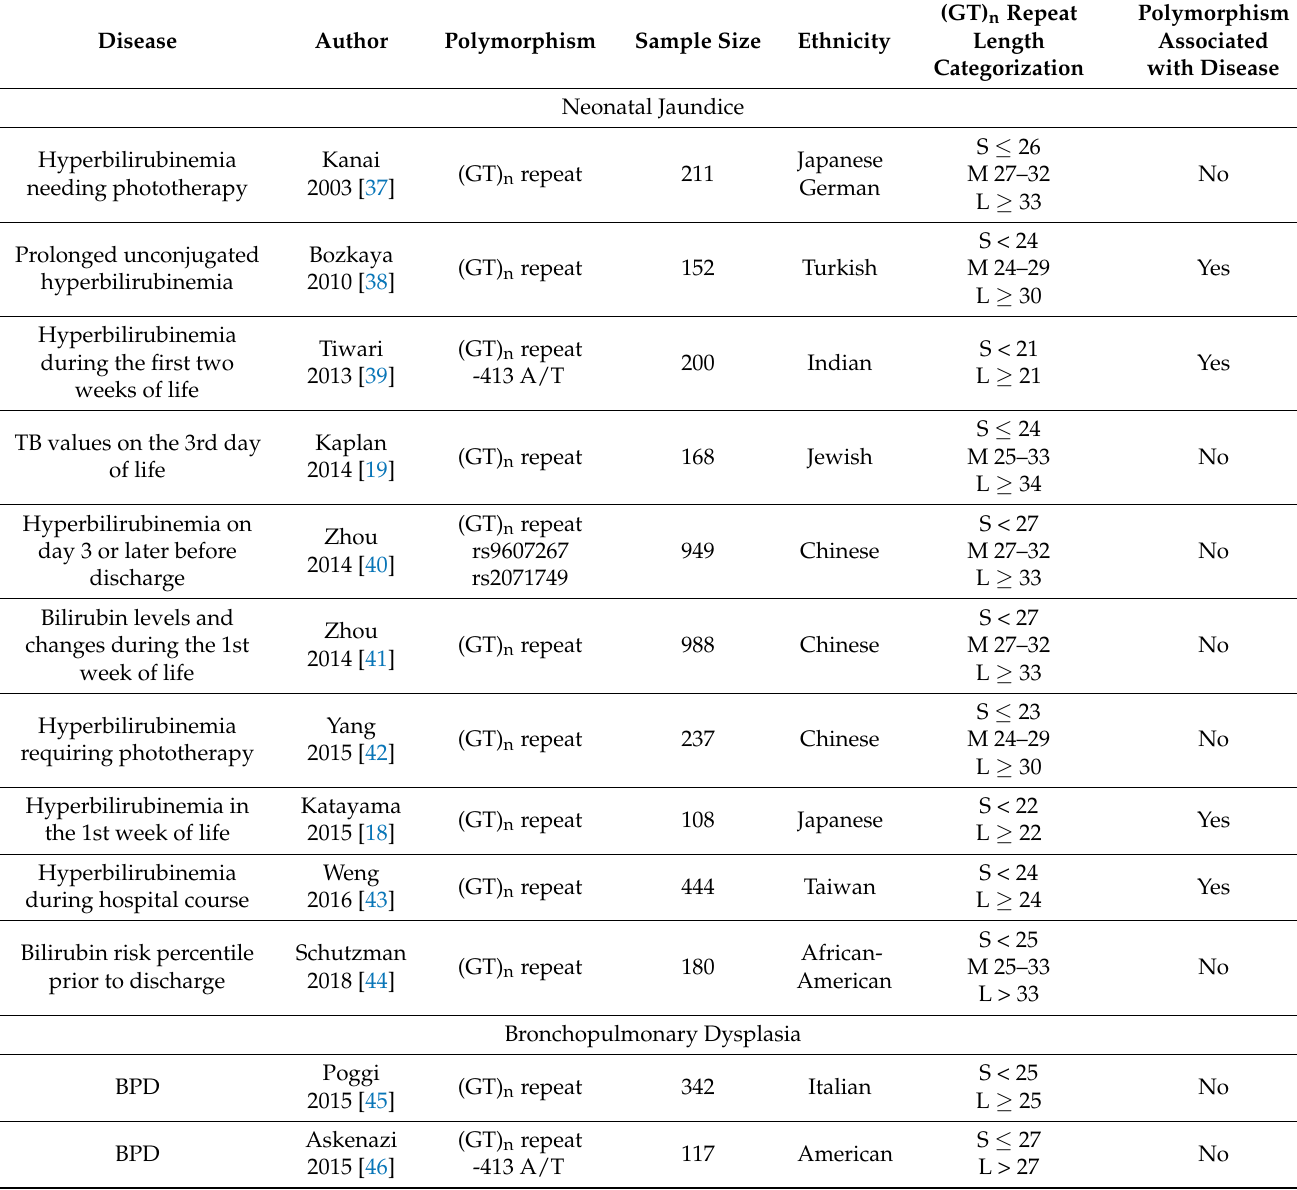
Table 1. Overview of the studies investigating the association between HMOX1 polymorphisms and perinatal morbidities. Disease Author Polymorphism Sample Size Ethnicity